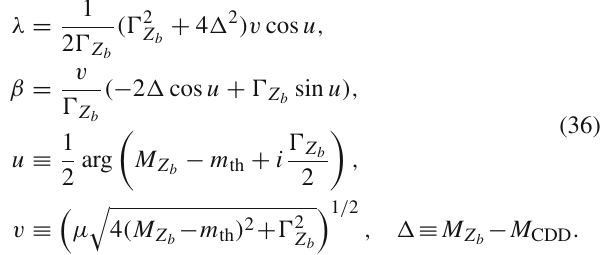
the B ( ∗ ) ¯ B ∗ thresholds. In each subfigure, the solid line corresponds to M CDD = m th case,wherethevalueofcompositeness X issmallest,0.39 for Z b ( 10610 ) and 0.36 for Z b ( 10650 ) ; the dashed line corresponds to X = 1